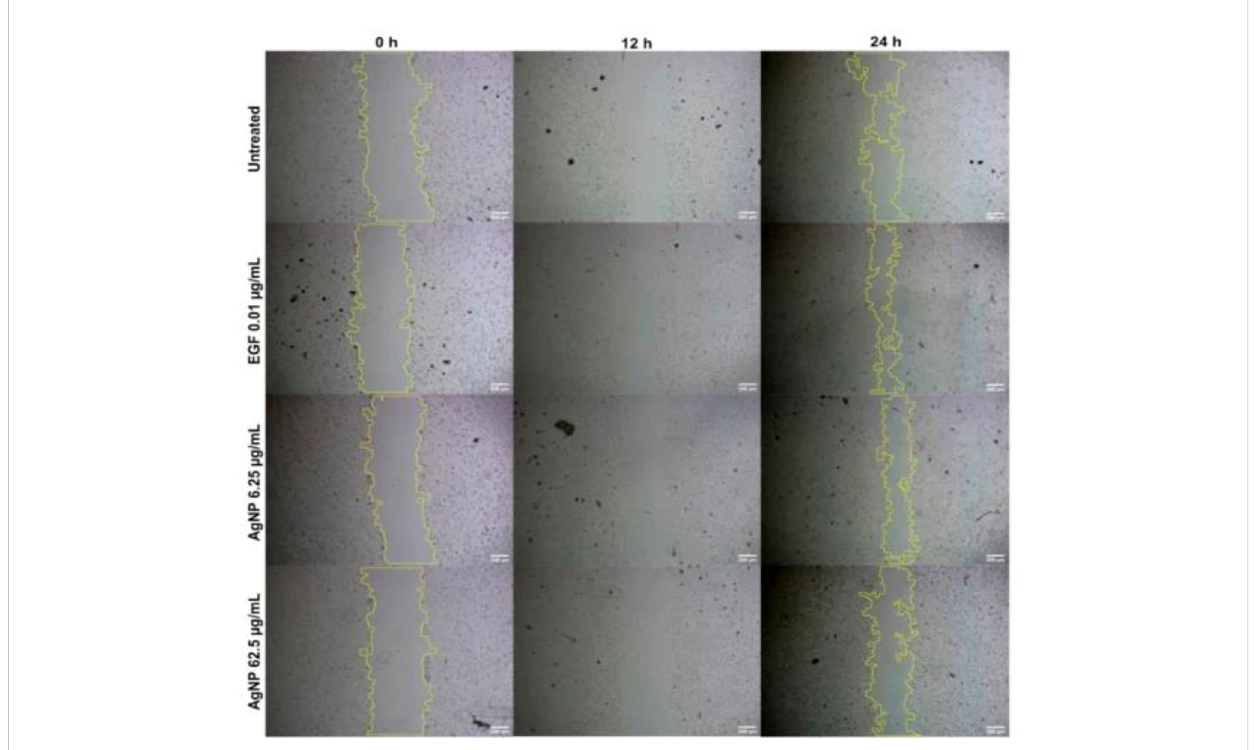
FIGURE 4 Untreated fi broblastcellular proliferation, presence of varied concentrations of MNPs, and standard EGF-mRNA. Reproducedwith permission (Dutt et al., 2023) Copyright 2023,